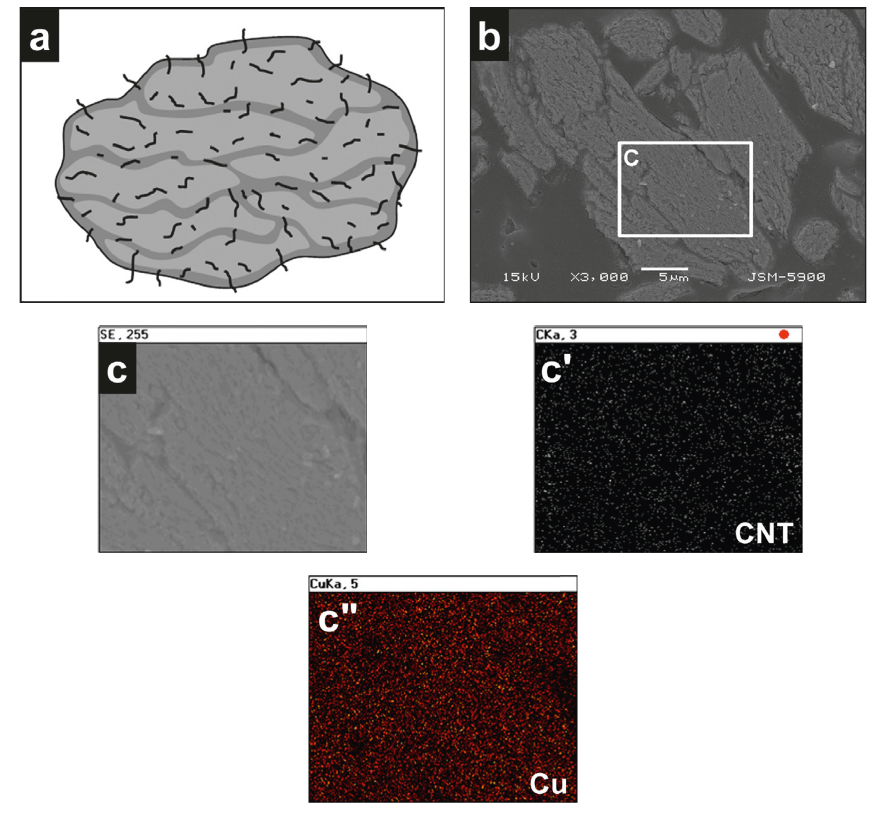
Figure 8: Cross-sectional view and EDX mapping of a ball-milled CNT-Cu MMC powder [41]. Table 2: CNT-reinforced MMC coatings produced by cold spray and their thermal properties [41–44, 65–68].